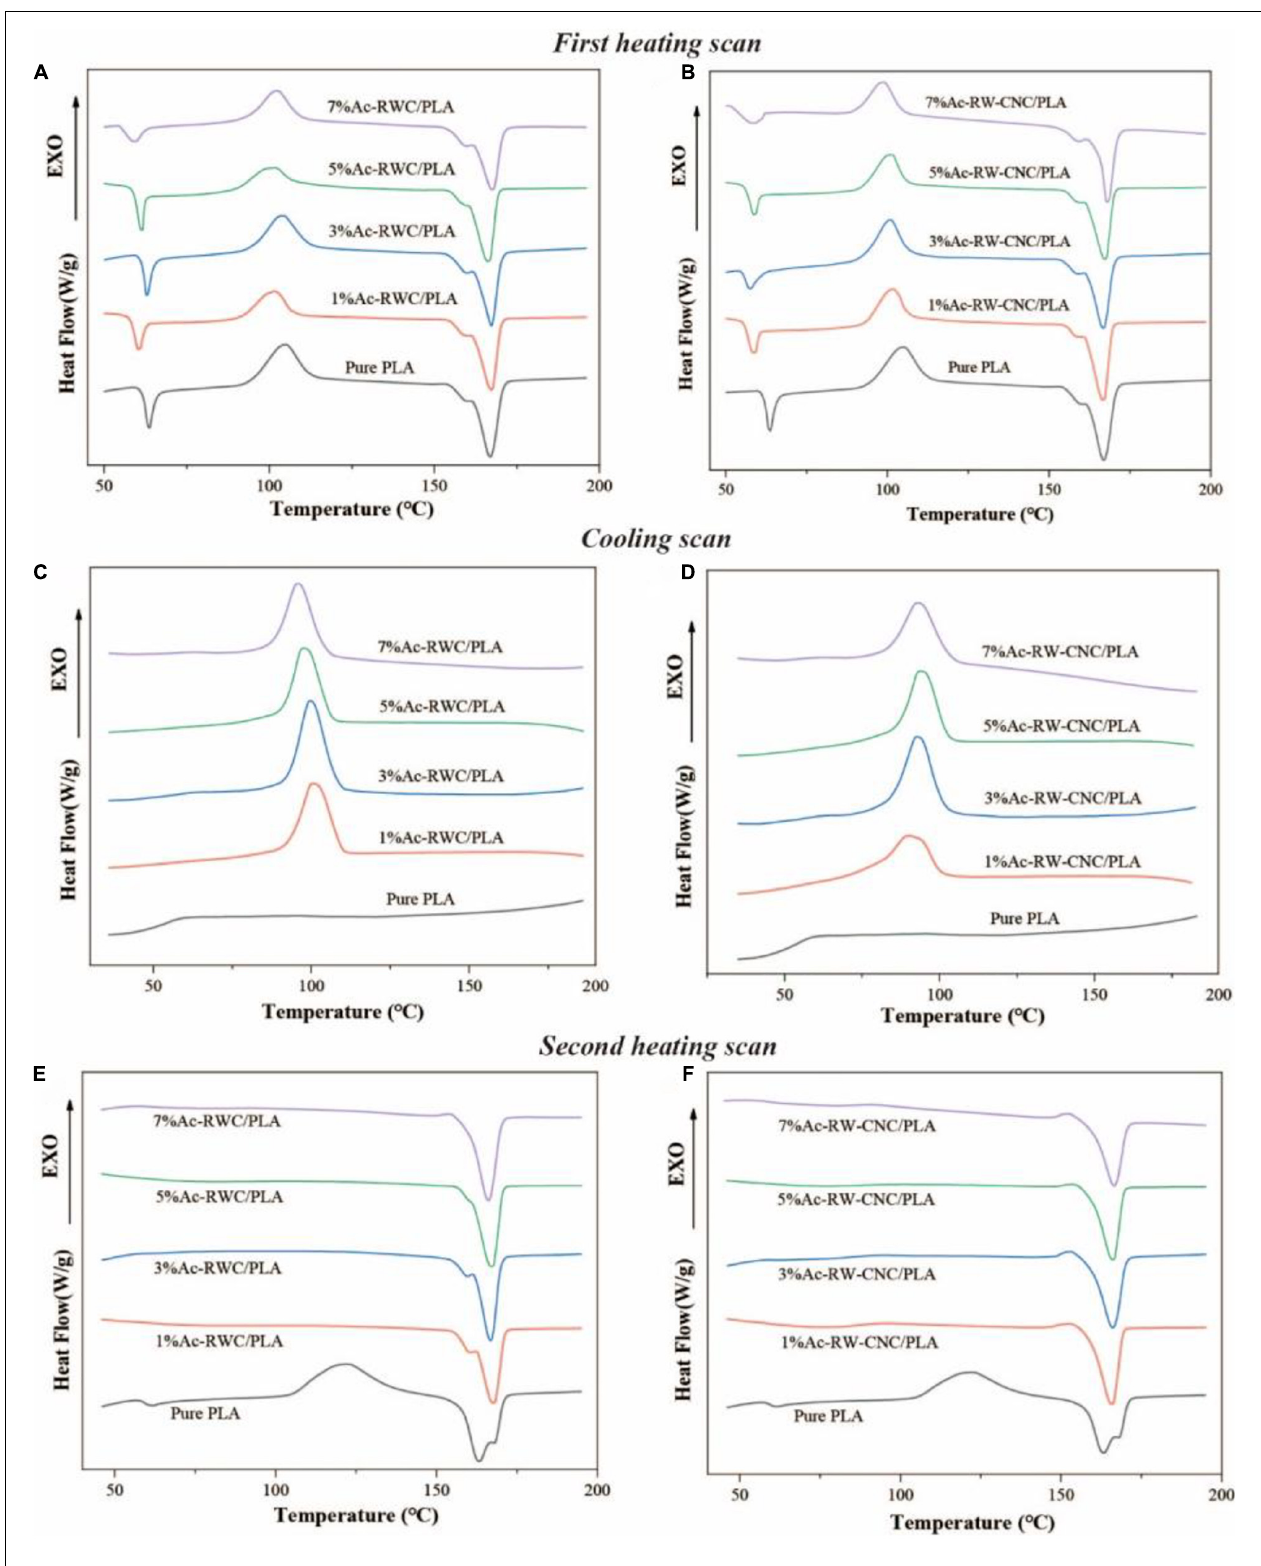
FIGURE 9 | DSC thermograms of PLA and PLA-based composite films. (A) The first heating scan of Ac-RWC/PLA composite films. (B) The first heating scan of Ac-RW-CNC/PLA composite films. (C) The cooling scan of Ac-RWC/PLA composite films. (D) The cooling scan of Ac-RW-CNC/PLA composite films. (E) The second heating scan of Ac-RWC/PLA composite films. (F) The second heating scan of Ac-RW-CNC/PLA composite films.